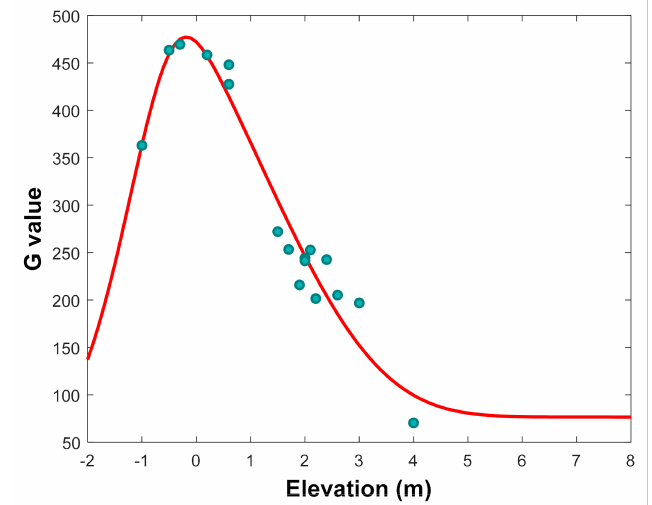
Figure 4. Fitted curve of model growth rate G (the red curve) of R. apiculata and the G values extracted from data (the round points) along elevation